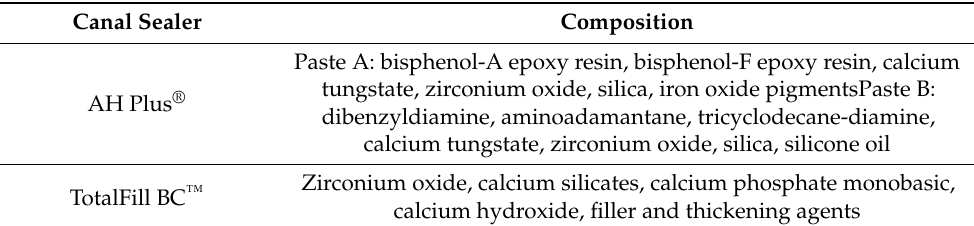
Table 1. Composition of root canal sealer